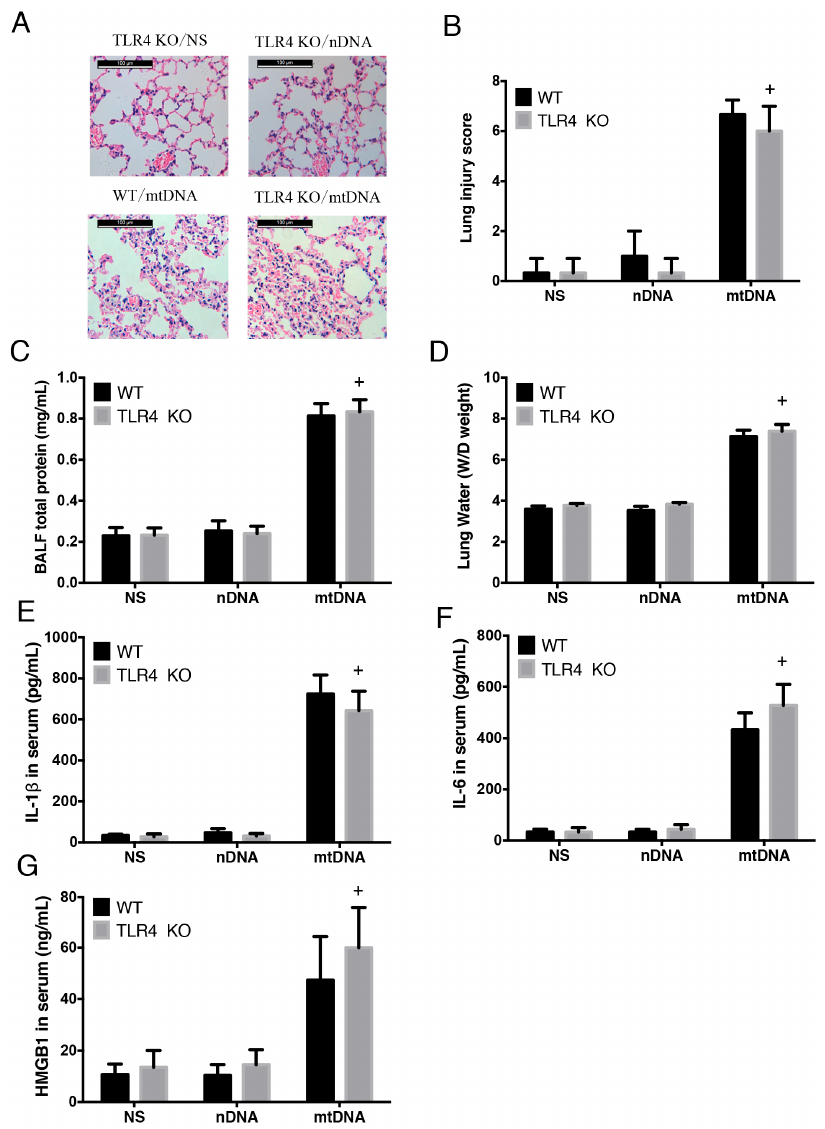
Figure 4. Intra-peritoneal administration of mtDNA induces acute lung injury and systemic inflammation in a TLR4-independent manner. WT and TLR4 KO mice were given NS, nDNA, and mtDNA administered intra-peritoneally ( n = 16/group, 8 for BALF only). Eight hours later, acute lung injury was measure by HE staining (scale bar is 100 μ m) ( A ) for lung injury score ( B ); BALF total protein concentration ( C ); and lung W/D ratio ( D ) were also analyzed. Systemic inflammation and circulating levels of IL-1 β ( E ); IL-6 ( F ); and HMGB1 ( G ) were measured by ELISA. + p > 0.05 versus WT/mtDNA group. Eight mice were used in each set and data are mean ± SEM of three separate experiments.